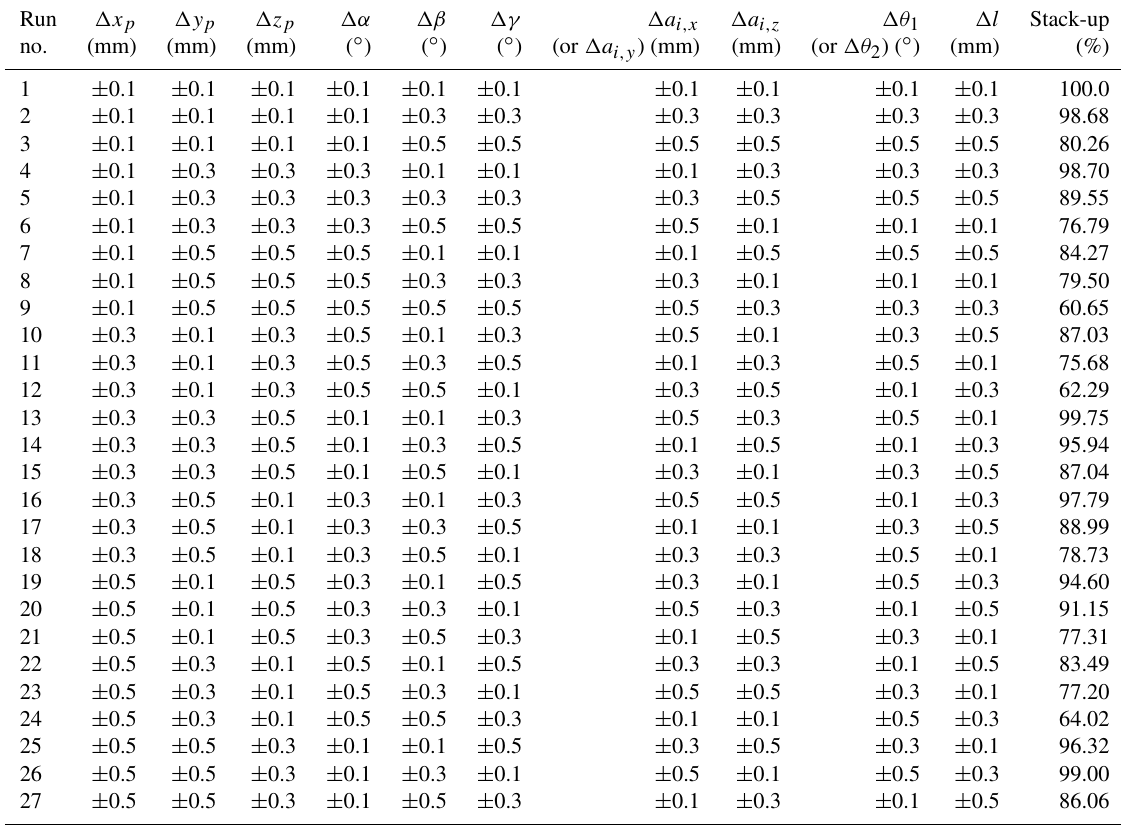
Table 6. L 27 (3 10 ) orthogonal array for responses with a sample size of 10 5 using Halton-set based MC